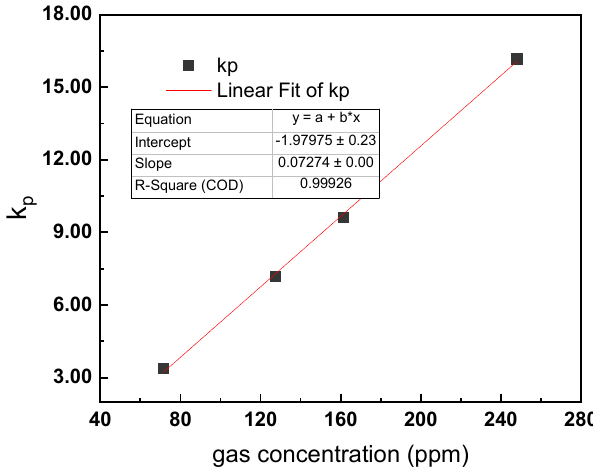
Figure 13. Linearity property of k p vs. gas concentration c.